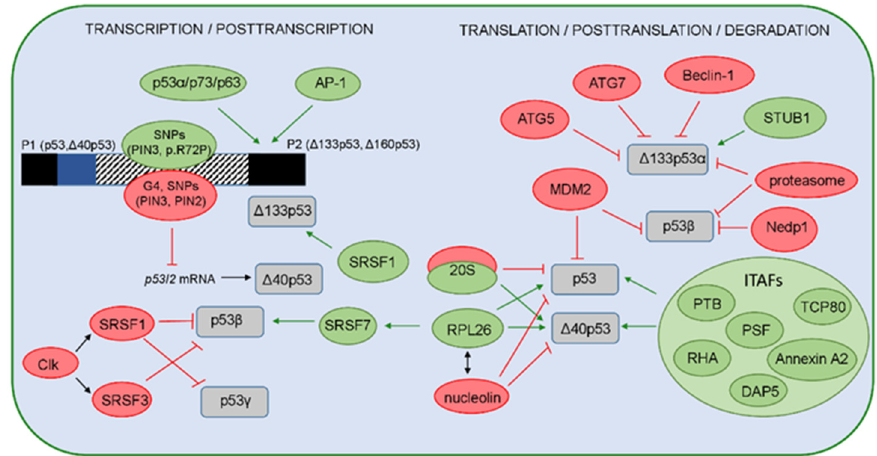
Figure 3. A model representing regulation of the p53 isoforms’ expression and stability. The positive regulators are shown in green, while the negative regulators are shown in red. On the transcriptional level, expression of the p53 isoforms is regulated by usage of two different promoters P1 or P2, producing the long (p53, Δ 40p53) or the short ( Δ 133p53, Δ 160p53) isoforms, respectively. Several regulators can influence the P2 activity. The canonical p53 and p53 family members (p63 and p73 and their isoforms) are shown to transactivate P2 with different efficiency. The transcription from P2 can be activated by the AP-1 transcription factor that mediates the expression of Δ 133p53 in H. pylori -infected cells. The single-nucleotide polymorphisms (SNP) and their haplotypes in the internal promoter region (shown as box with a striped pattern) that comprises intron 3, exon 4, and intron 4 can affect the P2 activities. Furthermore, the G4 structures, PIN3 and PIN2 polymorphisms, can decrease the level of the p53I2 mRNA that encodes the Δ 40p53 isoforms. The p53 isoforms are regulated on the posttranscriptional level by different splicing factors. SRSF1 and SRSF3, activated by Clk, promote complete exclusion of intron 9 and, thus, negatively regulate the level of p53 β and p53 γ isoforms. However, SRSF1 upregulates the Δ 133p53 α expression in human aortic smooth muscle cells. In addition, the binding of RPL26 to the TP53 pre-mRNA allows the recruitment of SRSF7 that prompts alternative splicing and, thus, generates p53 β isoforms. Due to IRES, the level of p53 and Δ 40p53 is regulated by ITAFs (PTB, Annexin A2, PSF, DAP5, TCP80, RHA) or proteins such as RPL26 or nucleolin. Interestingly, Δ 40p53 can be generated by the 20S proteasome that degrades the full-length p53 protein. The level of the full-length p53 protein is regulated by MDM2 that was shown to promote the degradation of p53 β . In addition, the level of p53 β is also regulated by the MDM2-dependent neddylation, proteasome, and deneddylating enzyme Nedp1. The level of the Δ 133p53 α isoform is regulated by the proteasome, as well as via autophagic degradation, upon replicative senescence, where the proautophagic proteins (ATG5, ATG7, Beclin-1) act as positive regulators, while the STUB1/CHIP acts as a negative regulator of Δ 133p53 α degradation and senescence.